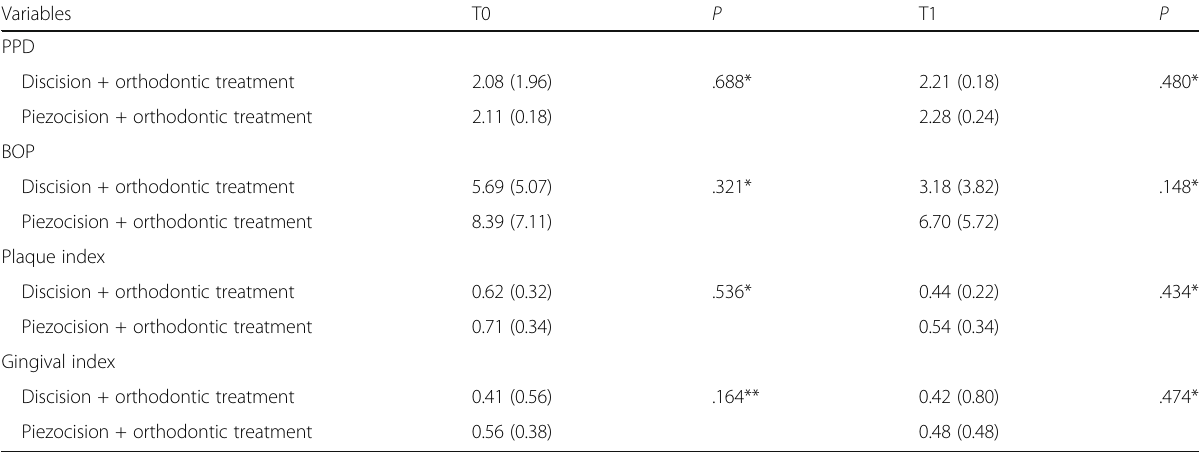
Table 2 Comparison of maxillary periodontal parameters in experimental groups according to different treatment periods Variables